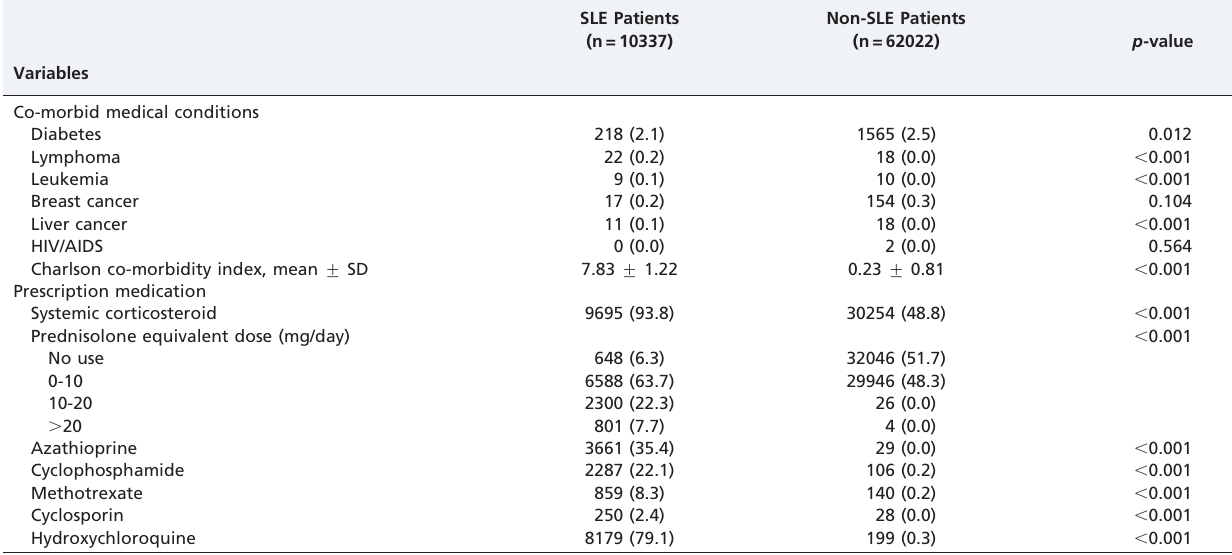
Table 2 - Comparison of co-morbidities and prescription medications between the SLE patients and the non-SLE controls.